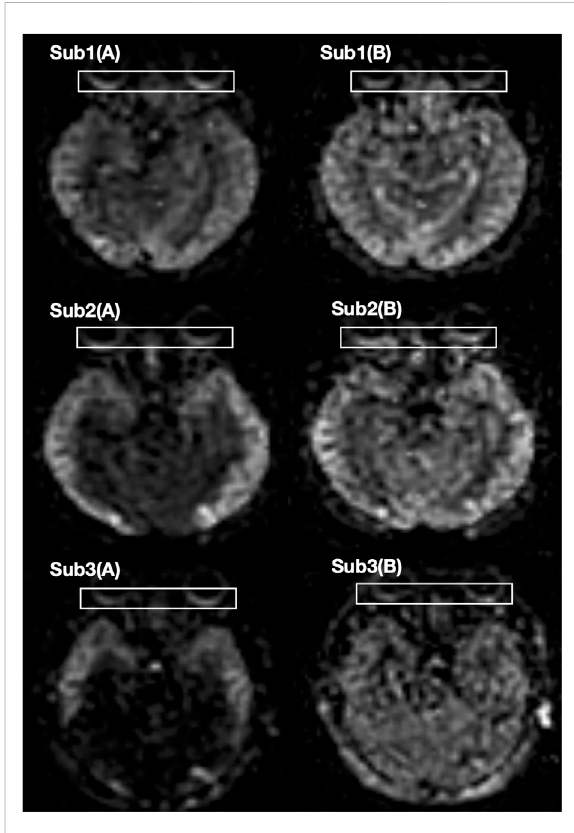
FIGURE 1 The OBF maps of three participants. (A) Before dobutamine injection (B) After dobutamine